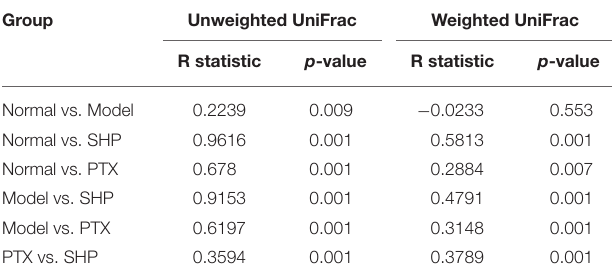
TABLE 3 | Result of the Analysis of similarities (ANOSIM).